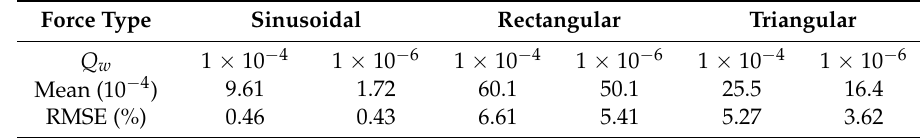
Figure 11. Location estimation of rectangular force ( Q w = 1 × 10 − 8 , σ = 1 × 10 − 16 ). Table 1. Estimation performance of three types forces with varying Q w ( σ = 1 × 10 − 8